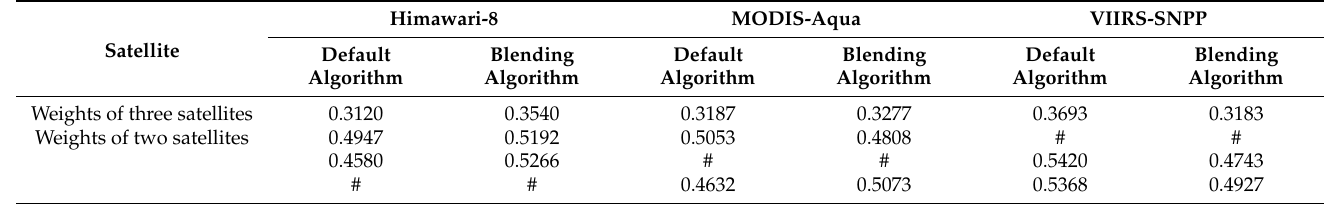
Table 10. Weights of satellites in the data merging process. The weights of three satellites are used when all three satellites have data in the same location; the weights of two satellites are used when only two satellites have data in a location.